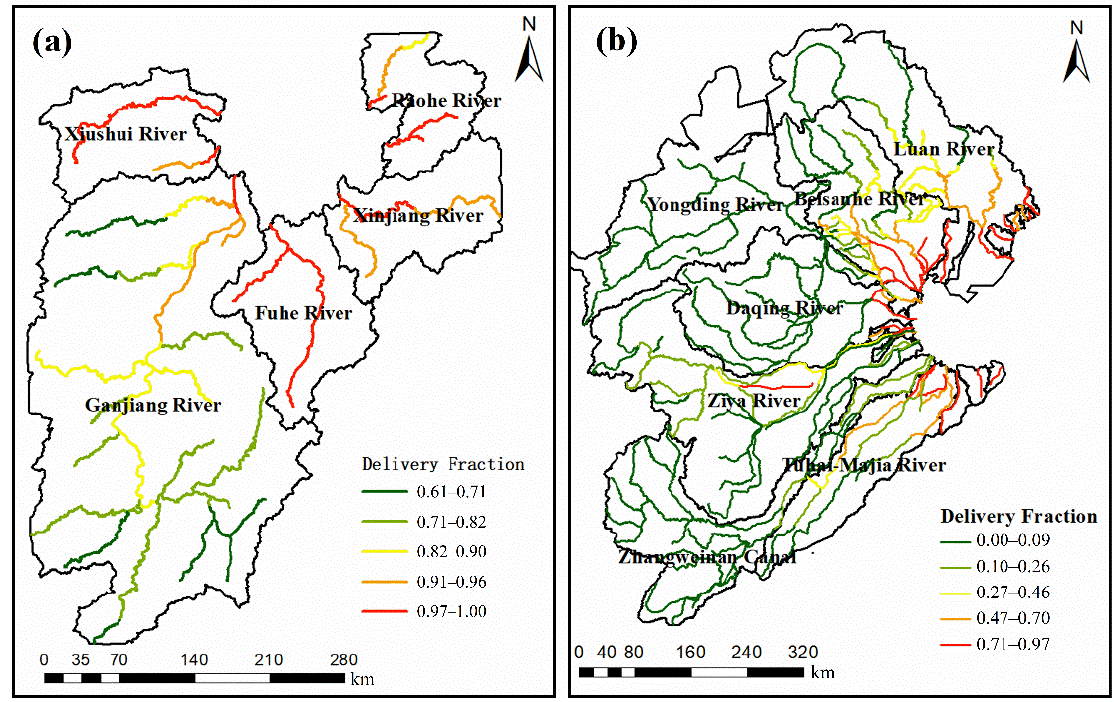
Figure 8. Delivery fractions in ( a ) PLB and ( b ) HRB.